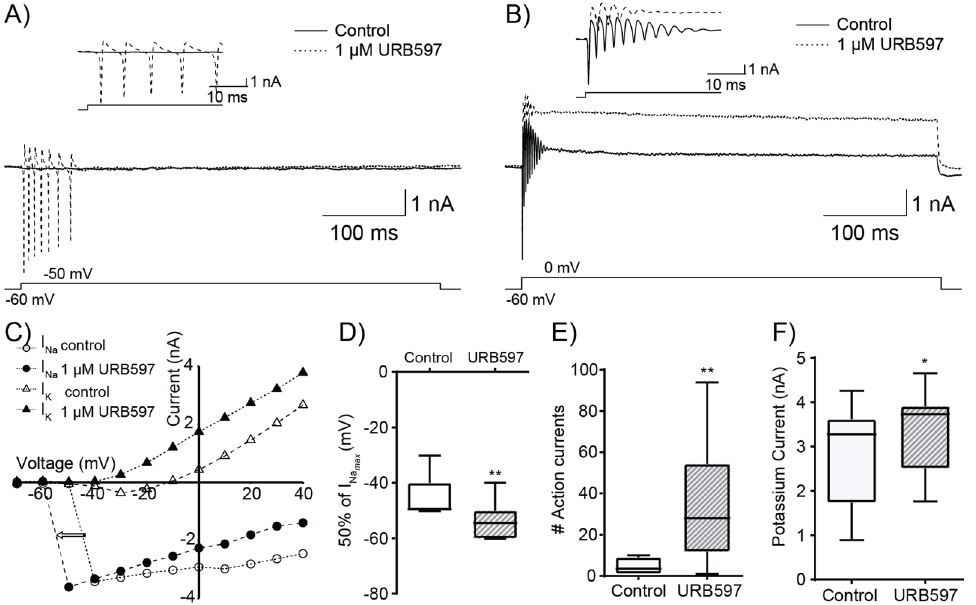
Figure 4. Application of the FAAH inhibitor URB597 alters excitability properties. ( A ) Representa- tive sodium current elicited by a 500 ms depolarizing step from − 60 mV to − 50 mV in control con- ditions (solid line) and after bath application of 1 µM URB597 (dashed line). Inset : same currents at an expanded time scale. ( B ) Representative K + currents elicited by a 500 ms depolarizing step from − 60 mV to 0 mV in control conditions (solid line) and after bath application of 1 µM URB597 (dashed line). Inset : same currents at an expanded time scale. ( C ) Current–voltage Na + and K + curves in con- trol (empty symbols) and after the application of URB597 (filled symbols) for the same cell. URB597 induced a leftward shift in the Na + current (arrow) and an increase in the magnitude of the K + cur- rent. ( D ) Membrane potential at which Na + current reaches 50% of its peak amplitude. URB597 sig- nificantly reduced the voltage of the mid-point of peak Na + current ( p = 0.01, n = 12). ( E ) Effect of 1 µM URB597 on the number of inward Na + currents evoked by depolarization to the lowest mem- brane potential that elicits Na + currents in control conditions. URB597 induced a large, significant increase in the number of Na + currents from 4.5 ± 1.2 events to 34.1 ± 9.5 events ( p = 0.01, n = 12). ( F ) Summary of the effect of URB597 on peak K + current amplitude. Mean K + current amplitude was significantly increased from 2.84 ± 0.32 nA in control conditions to 3.44 ± 0.27 nA in the presence of 1 µM URB597 ( p < 0.05, n = 12). * p < 0.05, ** p < 0.01.